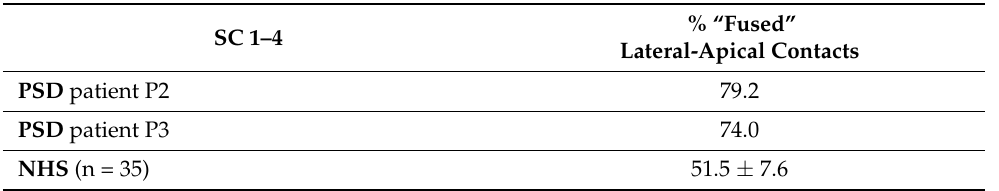
Table 4. Fraction of the apical-lateral contacts between corneocytes showing “fused” morphology in the SC of PSD. NHS = normal human